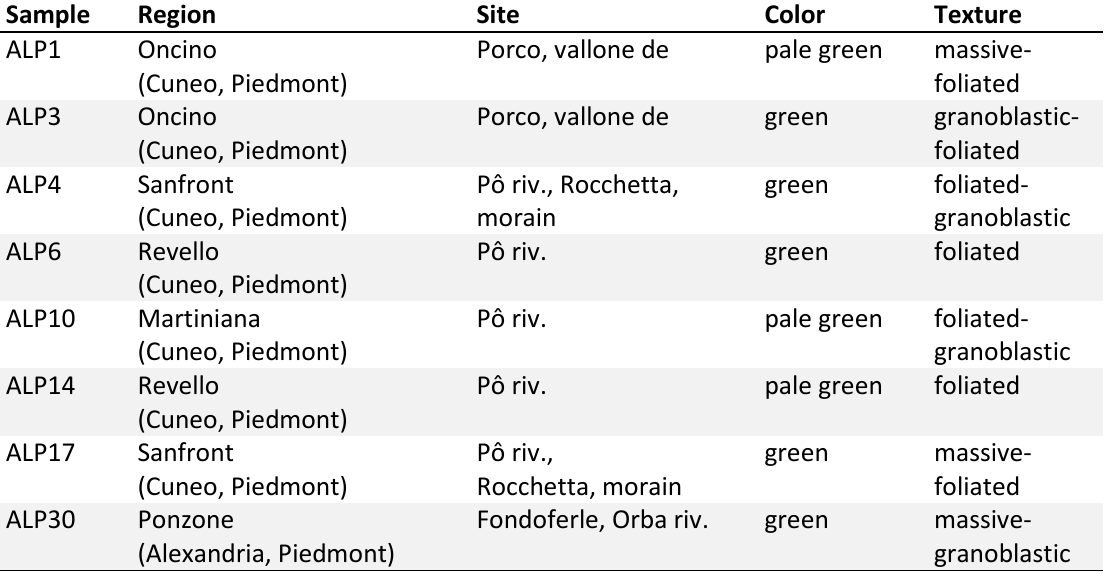
Table 1. Description of the geological samples. Produced by P Pétrequin and O. Lantes.